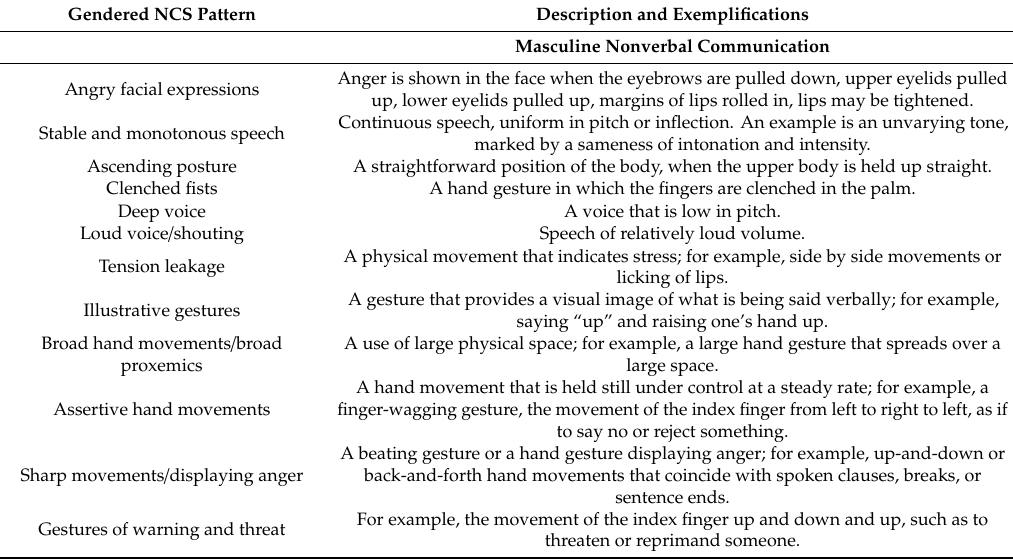
Table A1. Gendered NCS Patterns: Descriptions and